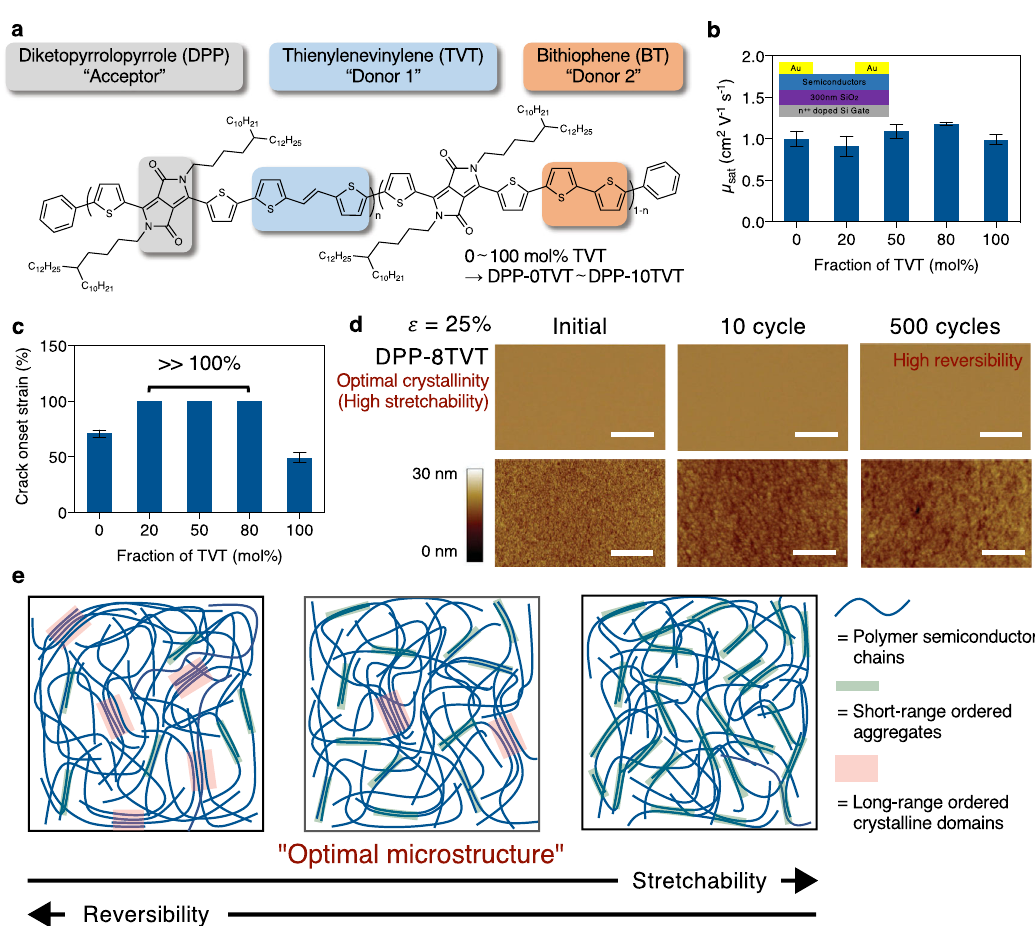
Fig. 1 Molecular design and properties of stretchable terpolymers. a Chemical structure of terpolymers used in this study. Based on the TVT unit fraction, terpolymers were named as DPP-0TVT (0 mol% TVT) ~ DPP-10TVT (100 mol% TVT). b Mobility of the terpolymers measured from top-contact-bottom- gate transistors given in the top left corner (measured in air). Error bars represent SD. c Crack onset strain of the terpolymers. Our terpolymers showed tremendous crack onset strain >100% strain. Error bars represent SD. d Optical and AFM images of 30 nm-thick semiconducting terpolymer fi lms after repeated 25% strain. DPP-8TVT showed high mechanical reversibility without wrinkling. The color scale of the AFM images represents relative height (scale bar: 10 µ m and 1 µ m for optical and AFM images, respectively). e Microstructures of polymer semiconductors that are ideal for stretchability and mechanical reversibility. Semi-crystalline polymer semiconductors with low crystallinity (such as DPP-8TVT) have optimal microstructures with balanced stretchability and mechanical